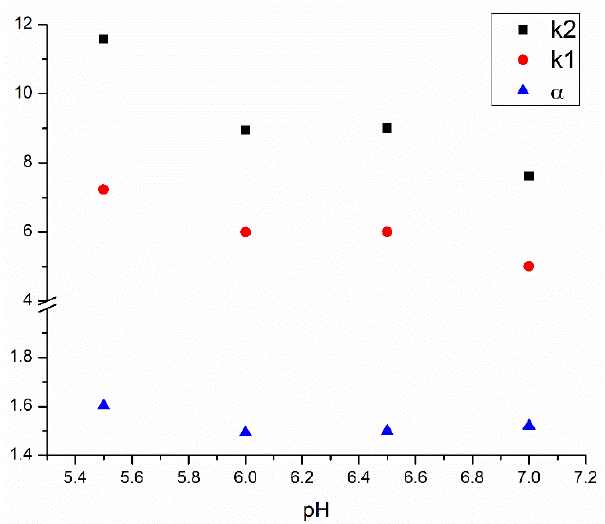
Figure 3. Influence of the pH of the phosphate buffer on the retention factors and